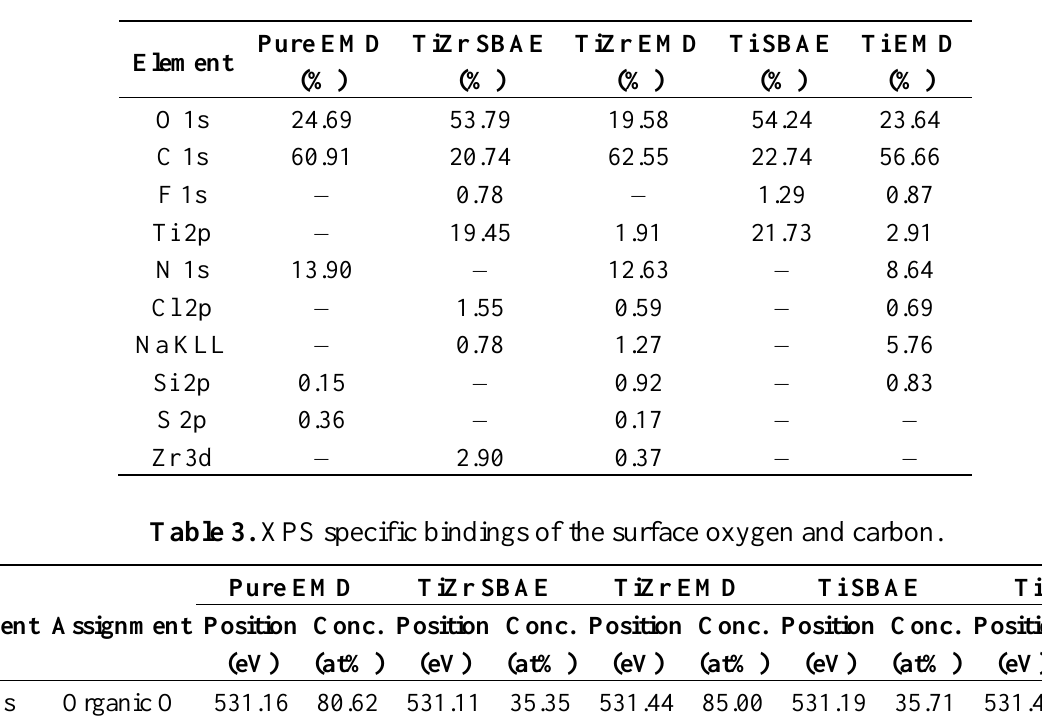
Table 2. XPS surface elements distribution.